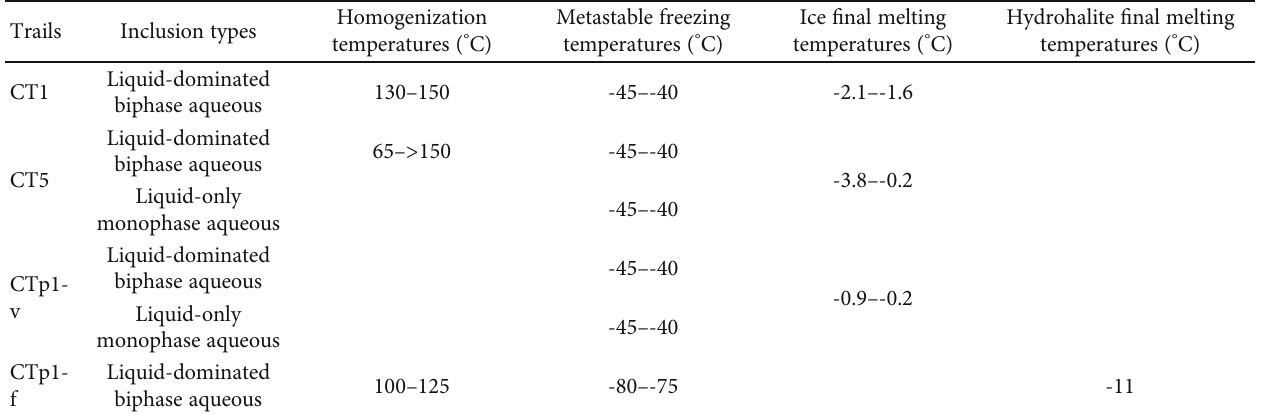
Table 2: Fluid inclusion microthermometric